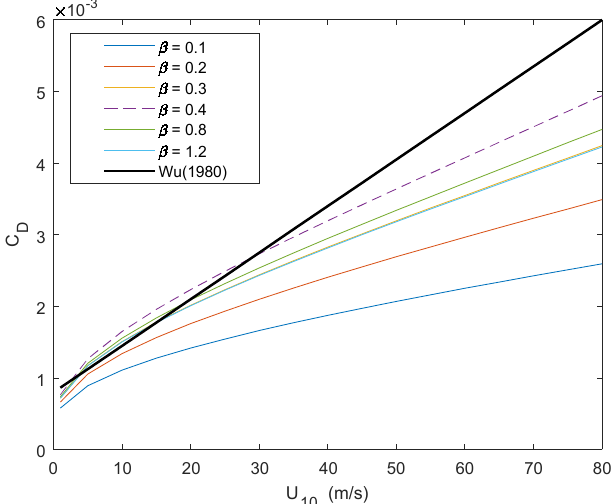
Figure 6. Variations of the sea surface drag coefficient with wind speed under different wave ages, without considering the impact of sea spray droplets. The dashed line ( β = 0.4) indicates that the variation trend of the sea surface drag coefficient with wave age began to change.